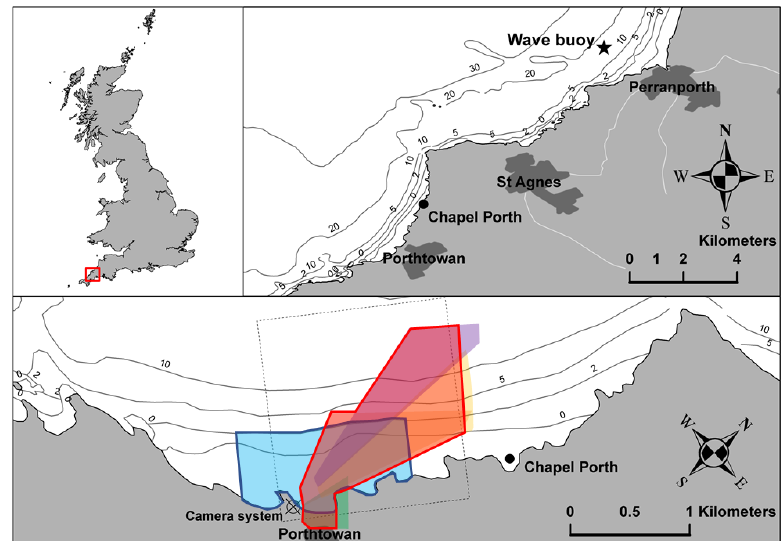
Figure 1. Overview of the national and local orientation of field site in this study. The top left figure shows Great Britain. The red square indicates the focus area in the South–West of England. The top-right shows the regional situation. Local wave data is obtained from the wave buoy 5 km North–East of Porthtowan, close to Perranporth. The bottom figure represents the local situation. The blue area represents the typical area that could be covered by the Real-Time Kinematic GPS (RTK-GPS) topography surveys. The colored triangles indicate the footprint for each video-camera. The red-lined area shows the total video area. The shape of the total video area deviates from the traditional Argus [42] field of views (near 180 degrees alongshore view) due to the local geology, orientation and lenses of the